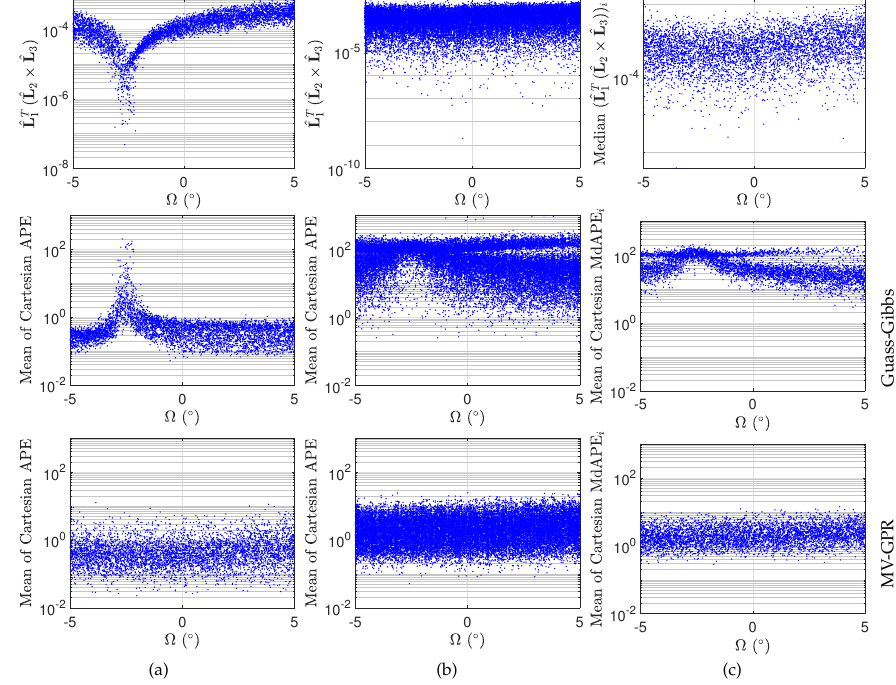
Figure 7. Effects of coplanarity on Gauss–Gibbs and MV-GPR IOD solutions. ( a ) scalar triple product of the lines-of-sight and average of the Cartesian APE versus true Ω given perfect measurements. ( b ) scalar triple product and average of the Cartesian APE versus true Ω given noisy measurements. ( c ) median scalar triple product and average of the MdAPE i versus true Ω for each set of five random samples of the 5000 test orbits.